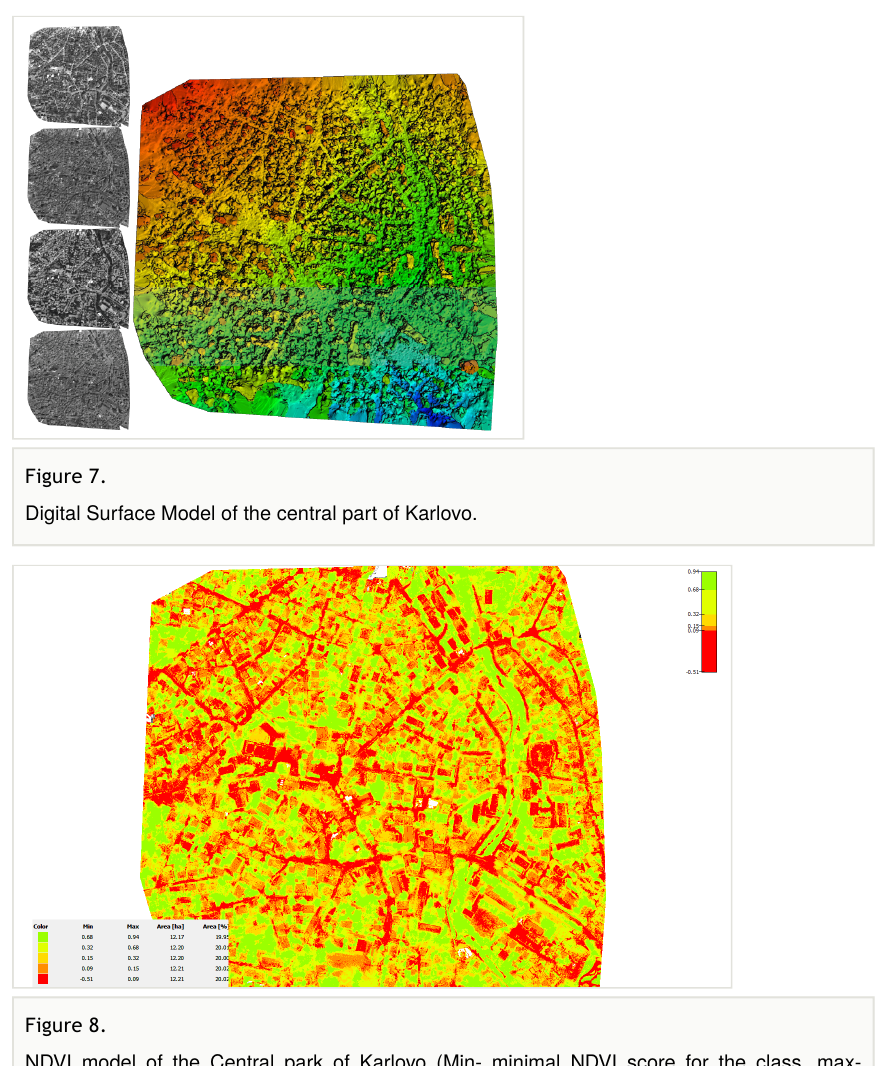
NDVI model of the Central park of Karlovo (Min- minimal NDVI score for the class, max- maximal NDVI score for the class, area (ha) total area of the NDVI class, area (%)- relative share of the NDVI class within the studied